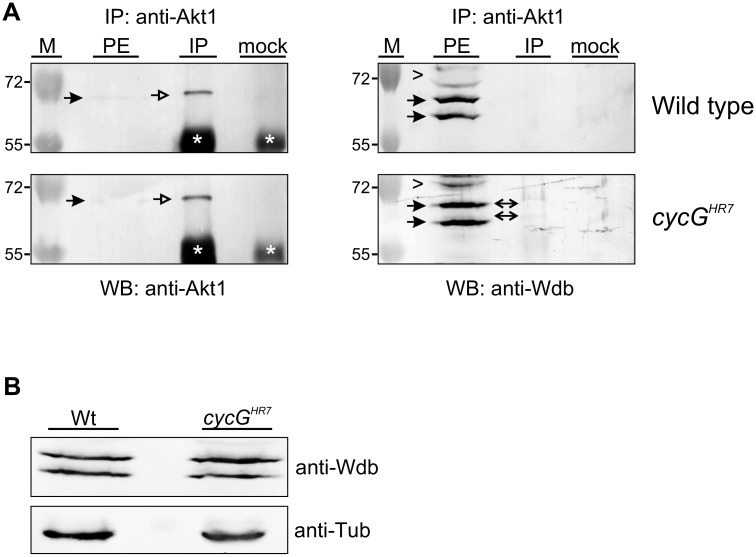
Influence of CycG on Akt1-Wdb binding.(A) Akt1 and Wdb proteins interact in vivo in cycG
HR7 mutants but not in the wild type. Akt1 proteins were immunoprecipitated (IP) from head extracts of either wild type or cycG
HR7 mutant animals and probed with anti-Akt1 (left panels, arrows) or anti-Wdb antibodies (right panels, arrows) as indicated. The input lane contained 25% of the protein extract (PE) used for the IP. Despite low Akt1 abundance in head extracts, Akt1 was robustly immunoprecipitated in wild type or cycG
HR7 mutants (left panels, open arrows), whereas Wdb protein was only co-precipitated in the mutant (right panels, double headed arrows). Arrowheads point to unspecific signals. Unrelated serum was used as mock control. The asterisks label unspecific IgG signals. M, size standard in kDa. (B) Wdb proteins were detected by Western blotting in head extracts of either cycG
HR7mutants or wild type (Wt) control as indicated. Beta-Tubulin (Tub) served as loading control.